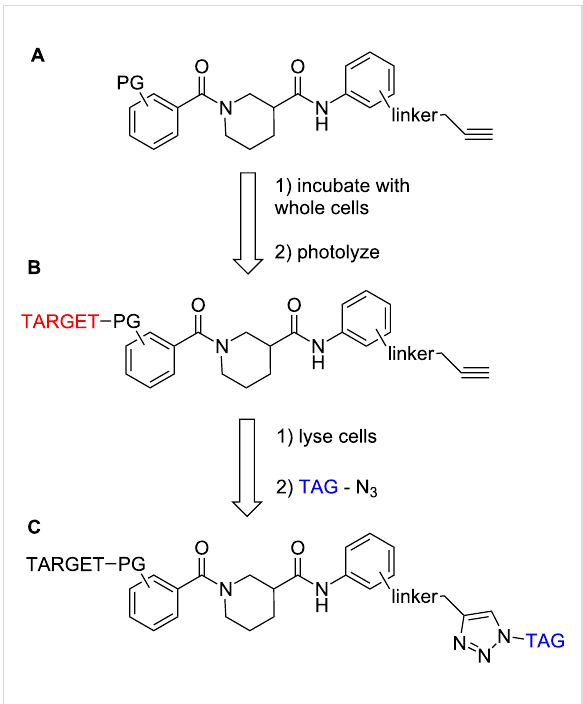
Figure 2: Strategy for tag-free photolabeling in whole cells (PG = photoactivatable group, TAG = fluorescent group or